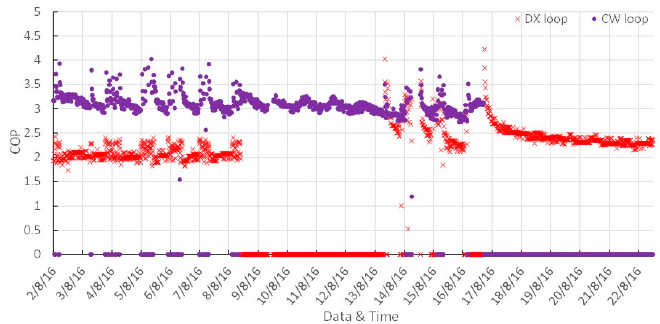
Figure 6. Coefficients of performance (COP) of both ground loop systems observed between August 1 and August 22, 2016.